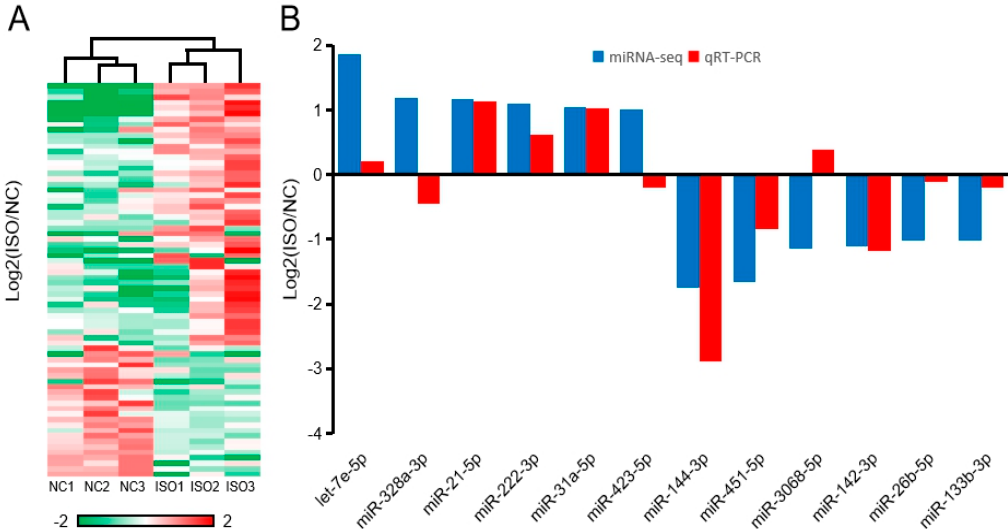
Figure 3. Validation of differentially expressed miRNAs by qRT-PCR. ( A ) The heat maps show the expression of miRNAs detected by sequencing. ( B ) The expression of miRNAs (Among the top 100 highly expressed miRNAs, Fold change ≥ 2 or Fold change ≤ 0.5) detected by RT-qPCR.